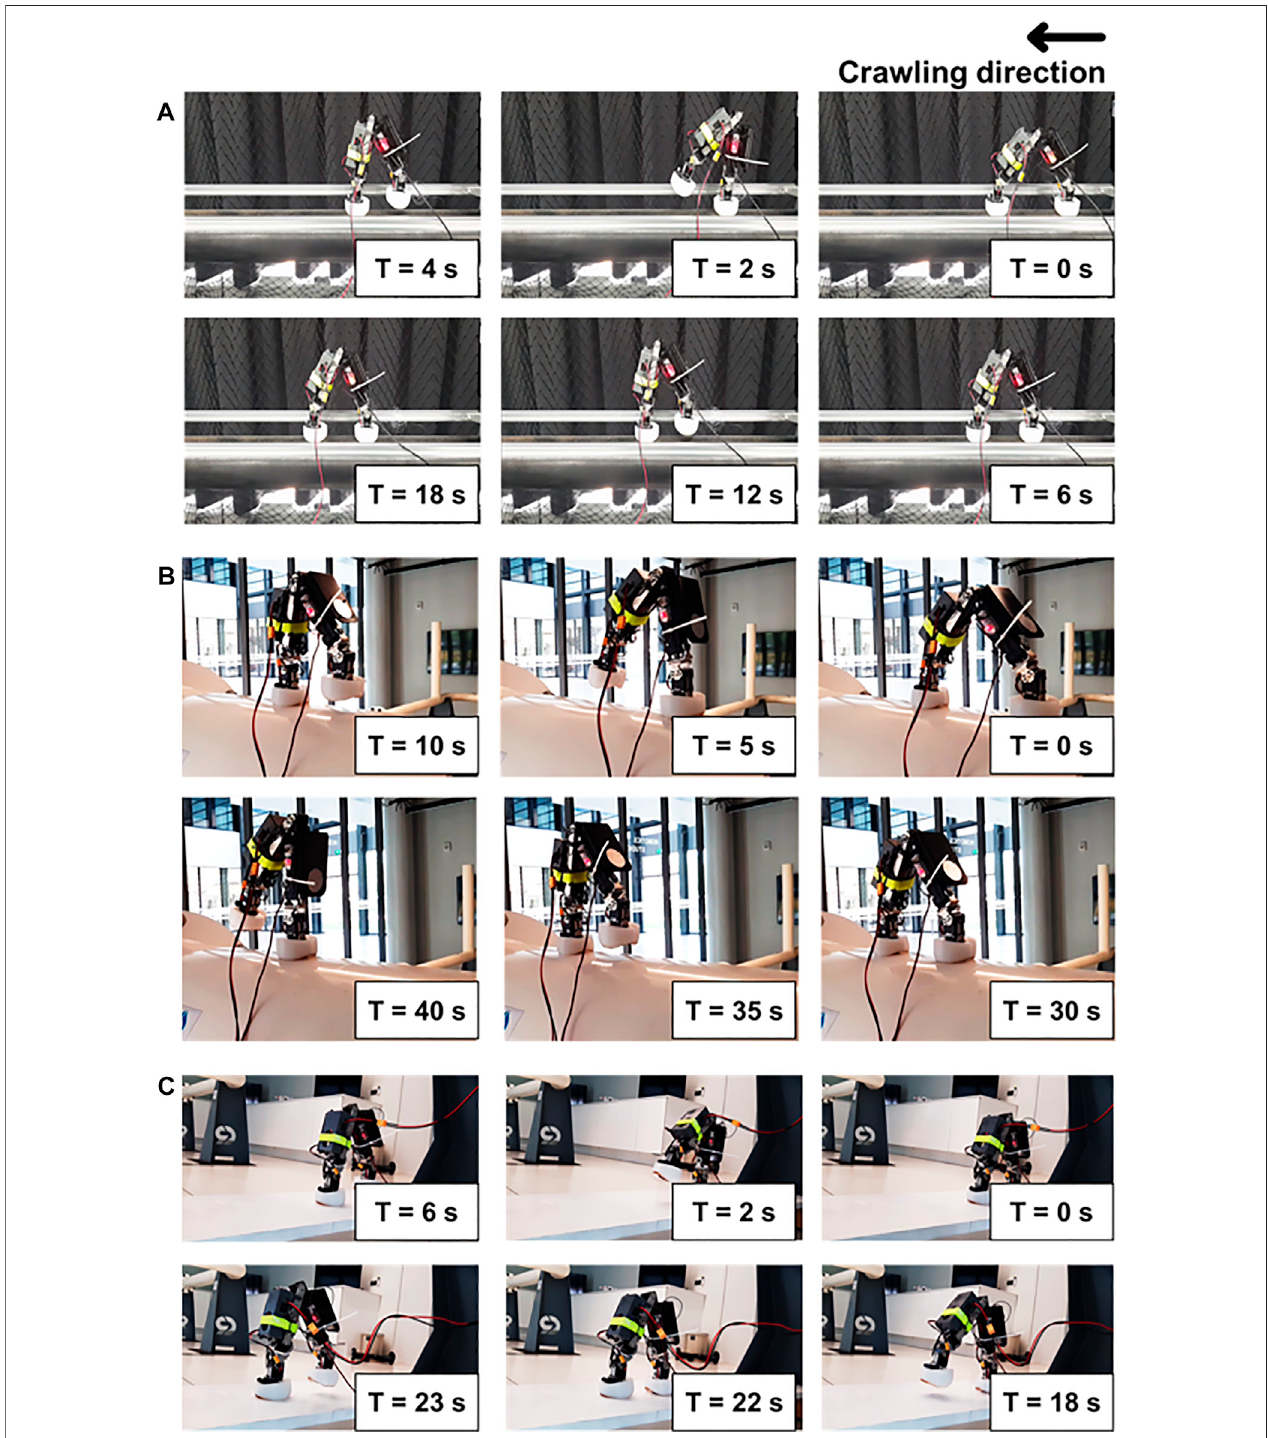
FIGURE 11 | The inchworm-inspired crawling robot performing point-to-point locomotion on metal pipes: (A) pipe diameter = 16 cm, (B) pipe diameter = 60 cm, and (C) fl at metalplate,usingthehybrid rigid-soft foot and steppinggait .Therobot crawlingspeed withthestepping gait was8.9 mm/s. Using theslidinggait, therobot speed was 25 mm/s. A supplementary video of the experiments can be viewed at http://www.manoonpong.com/EROFT/videoS1.mp4.